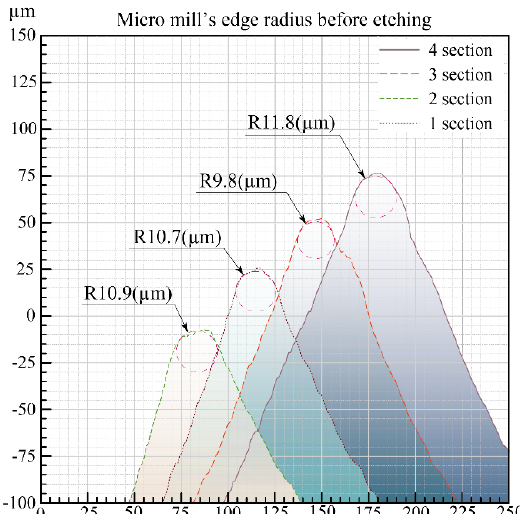
Figure 5. Cutting edge radii r eA1 , r eA2 , r eA3 , and r eA4 in four sections distanced from the mill end at 2 mm and distanced from each other at 0.05